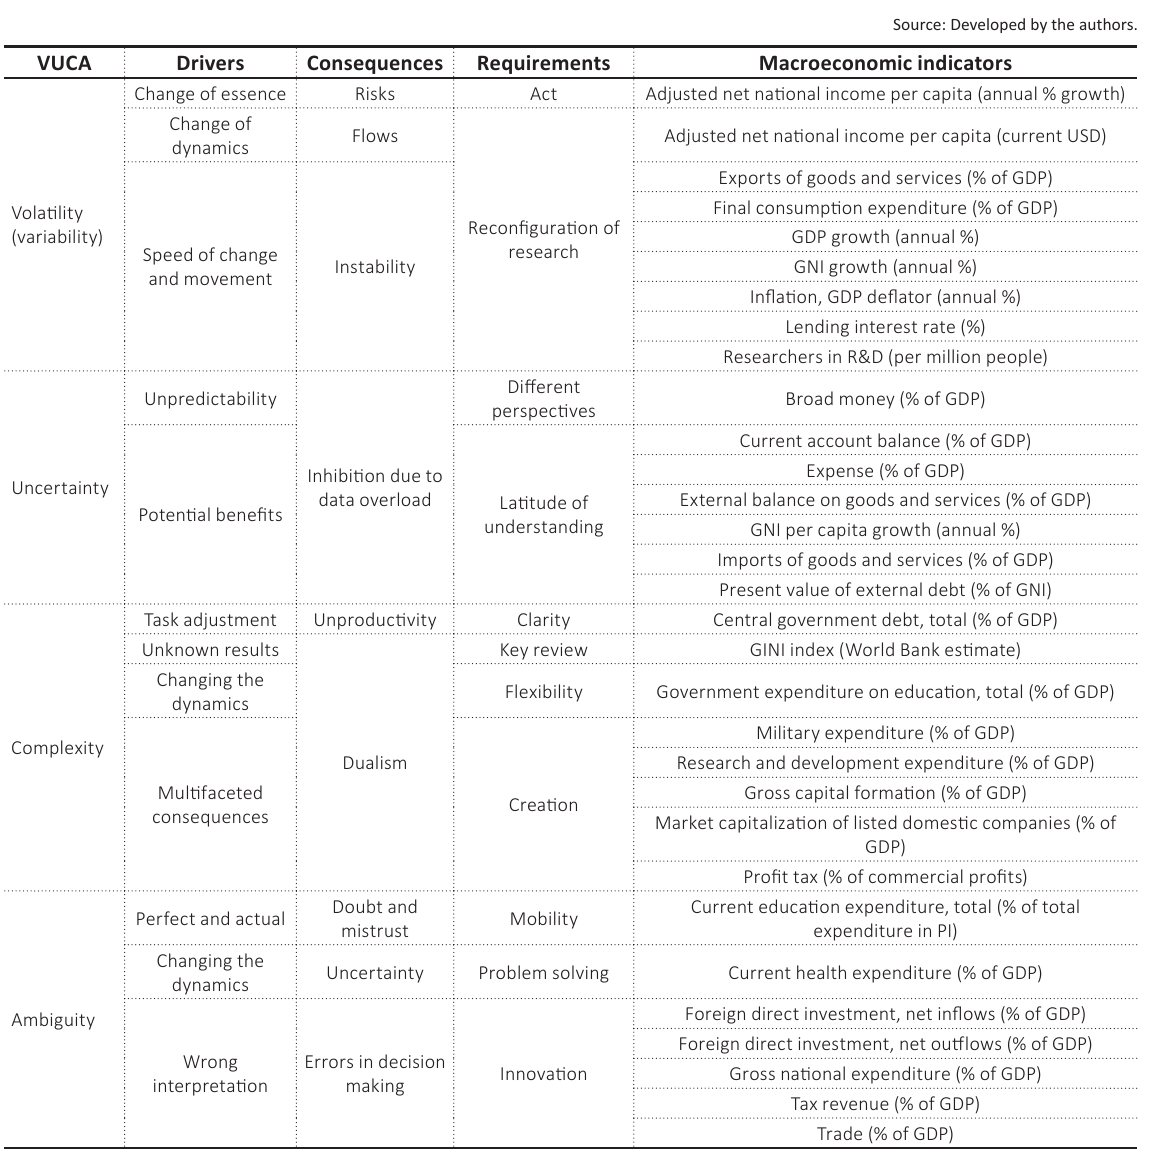
Figure 2. Average ranks of the Gini index of the Eastern European countries for the period 2010–2019 Table 3. System for studying the impact of modern business space “VUCA” on the analysis of financial stability of the country’s